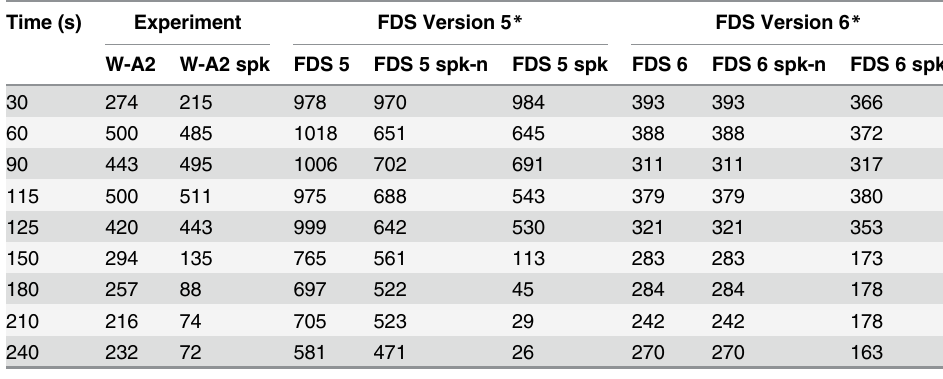
Table 4. Temperature at different times for various